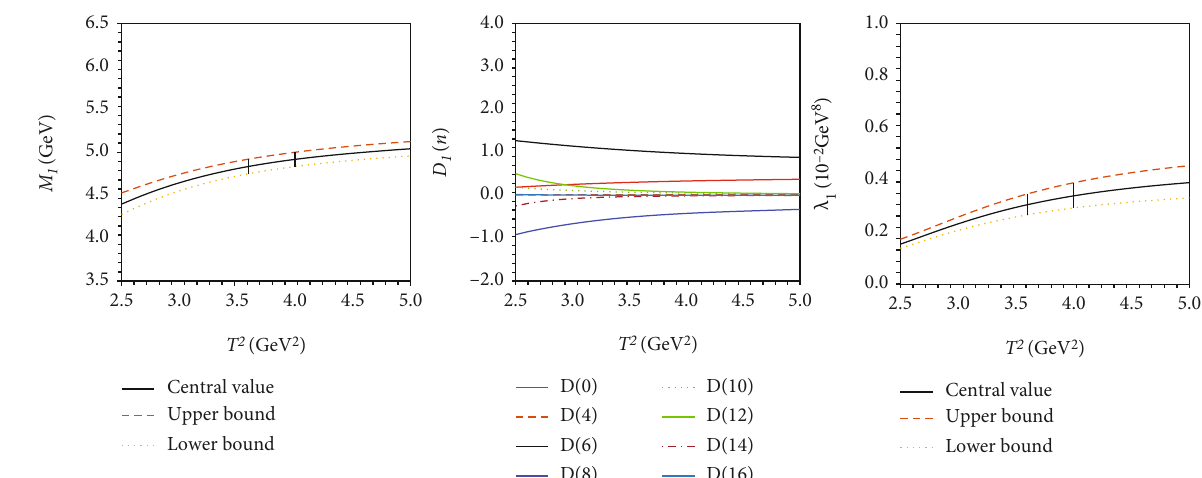
− T 2 for (a), dashed curve is drawn from the upper values of the input parameters and dotted : M 1 1 ð n Þ − T 2 for (b); λ − T 2 for (c), dashed curve is drawn from the upper values of the input parameters 1 1